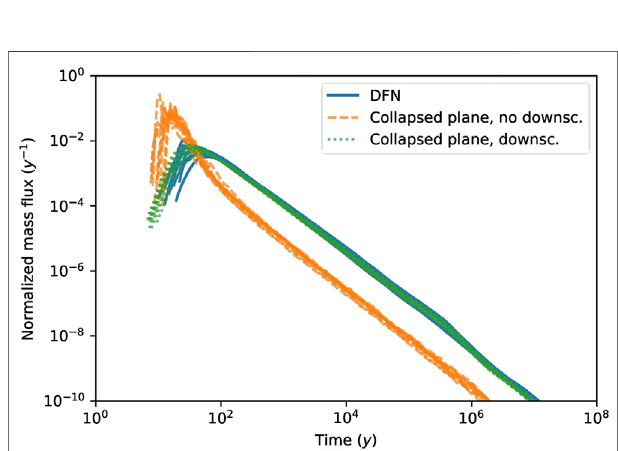
FIGURE 6 | Conservative case : breakthrough curves of a non-sorbing non-decaying radionuclide computed using transport pathways obtained using the different realisations of the DFN model (blue continuous curves) comparedwithrelatedcalculationscarriedoutusingtransportpathways derived from the collapsed plane model and without downscaling (orange dashed lines) and with related calculations where downscaling is applied (green dotted line).